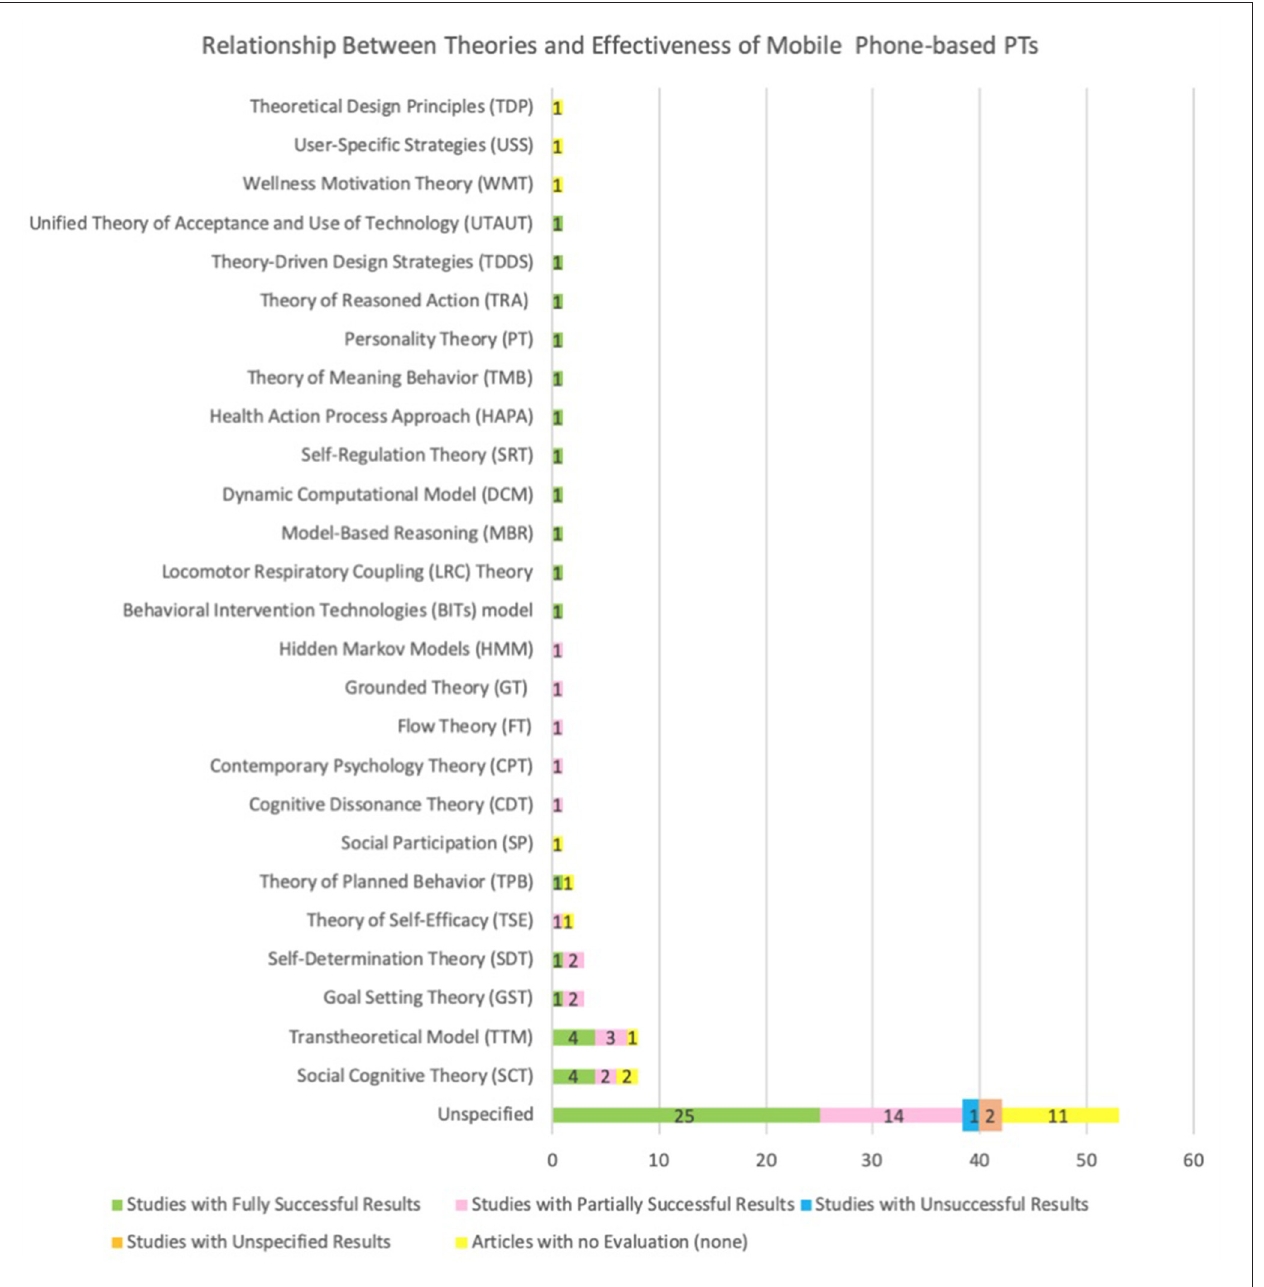
FIGURE 10 | The relationship between behavior theory and the effectiveness of mobile phone-based persuasive technology